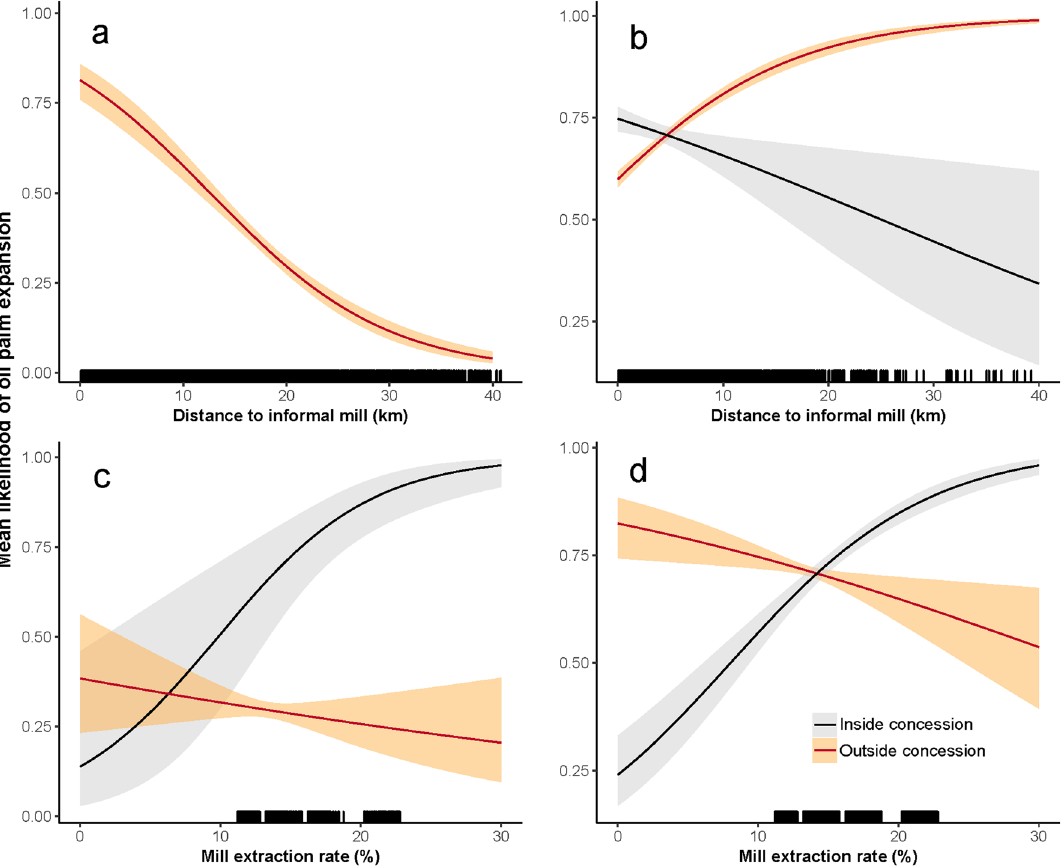
Fig. 5 Partial dependence plots. a – d Differences in the predicted mean likelihood of oil palm expansion ( a , c ) and expansion resulting in deforestation ( b , d ) inside and outside agro-industrial concessions as a function of distance to informal mill and mill extraction rate. The predicted mean likelihood of oil palm expansion inside concessions as a function of distance to informal mill is omitted from panel a due to the variable ’ s lack of statistical signi fi cance. Shaded areas around each line correspond to predicted mean likelihood 95% con fi dence intervals calculated using White – Huber standard errors from the oil palm expansion model ( n = 1,929,816) and deforestation model ( n =